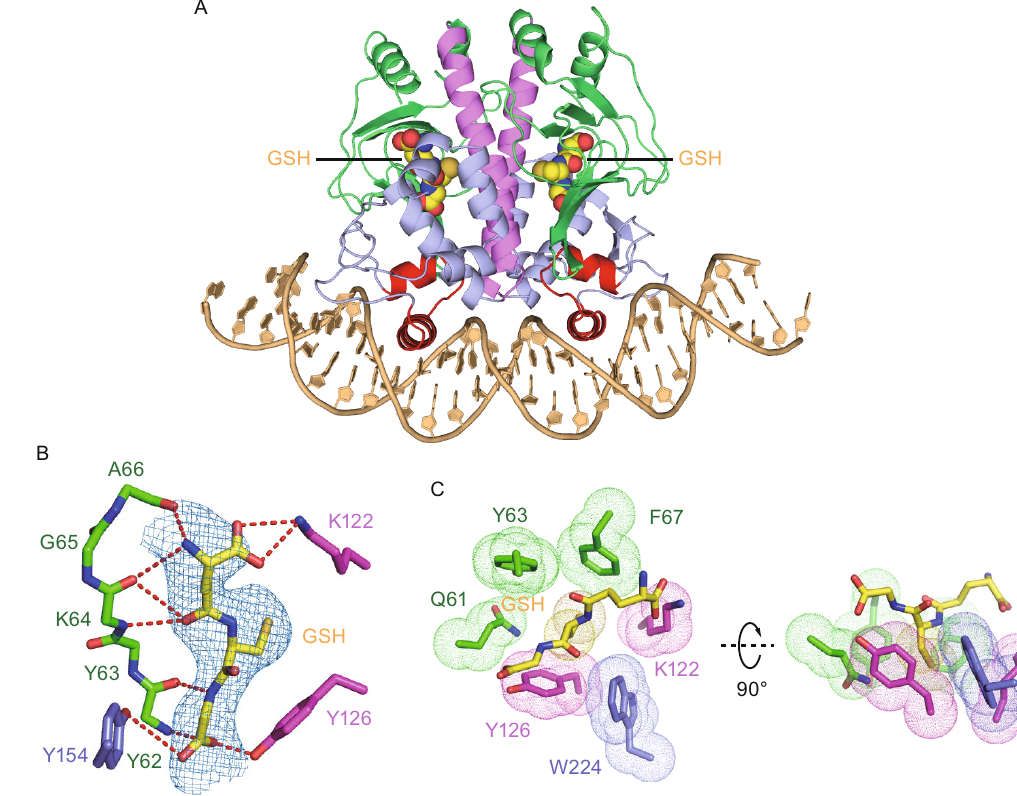
concentration glutathione solution. The overall structure of the ternary complex (Fig. 2A) is very similar to PrfA-DNA binary complex (Figs. 1A and S1E), with no further